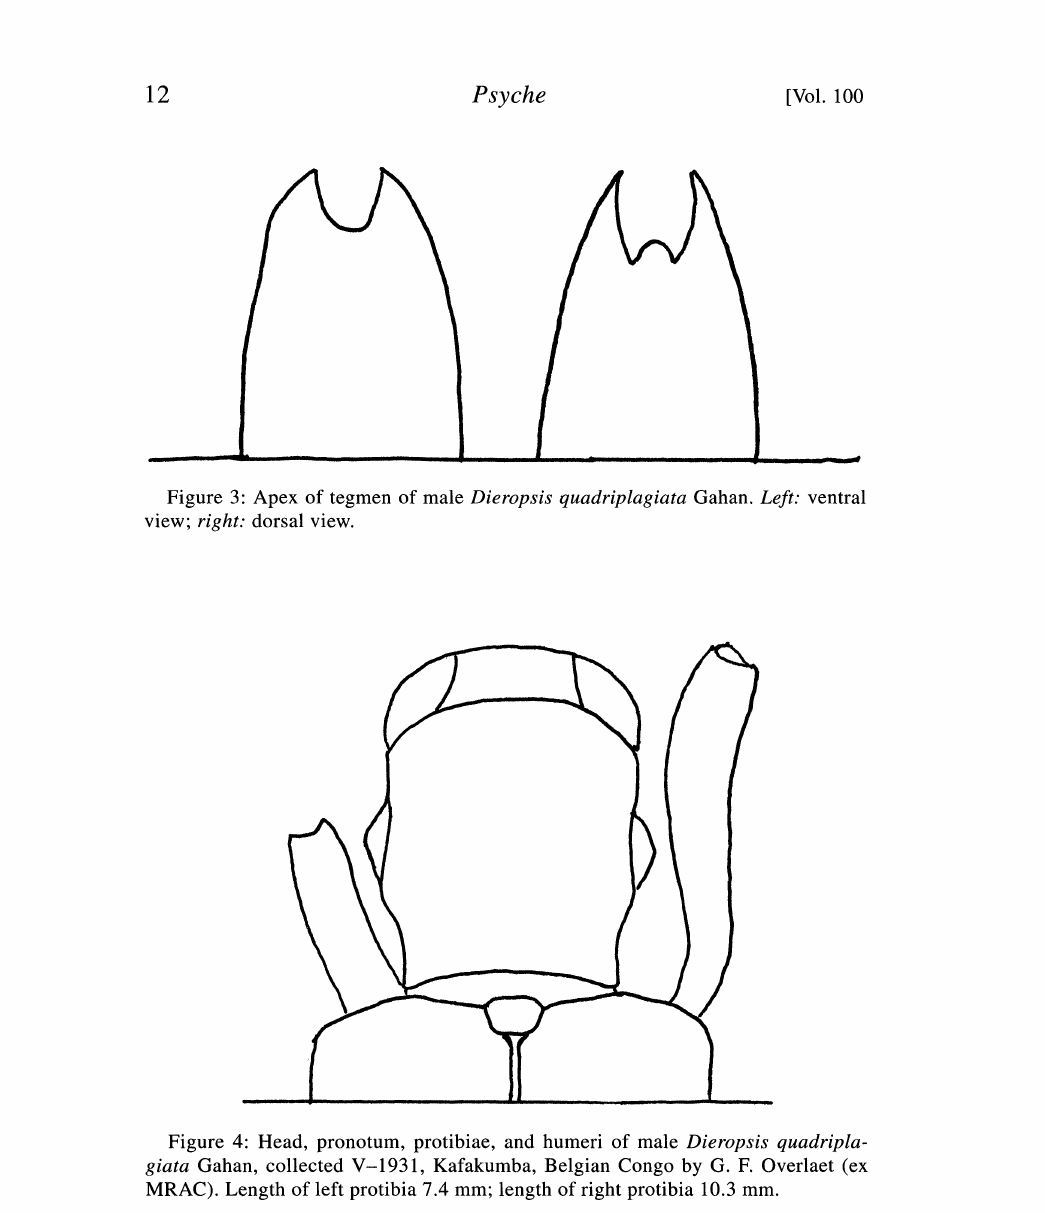
Figure 4: Head, pronotum, protibiae, and humeri of male Dieropsis quadripla- giata Gahan, collected V-1931, Kafakumba, Belgian Congo by G. F. Overlaet (ex MRAC). Length of left protibia 7.4 mm; length of right protibia 10.3